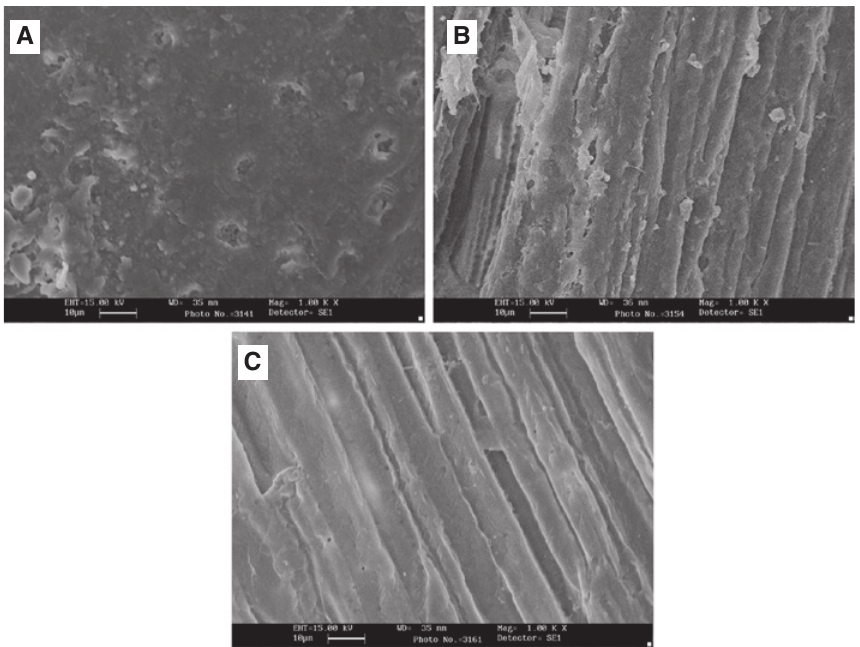
Figure 3: SEM micrographs of the coir fibers: (A) untreated (CF), (B) alkali-treated (A-CF), and (C) acrylic acid-treated